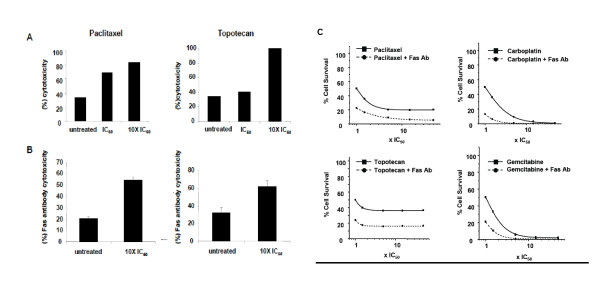
Tumor cells surviving topotecan or paclitaxel are sensitized to effector T cells. (A) In vitro exposure to paclitaxel or topotecan enhances the sensitivity of ID8-E6E7 cells to activated E7-specific T cells. Bars show cytotoxicity after exposure to 2 different doses of paclitaxel and topotecan (IC50 and 10 fold IC50) for the same E:T ratio (20:1). Experiments were performed twice with similar results. (B) Treatment of ID8 cells with topotecan or paclitaxel sensitizes them to Fas agonistic antibody. ID8 cells (untreated or treated with topotecan or paclitaxel at IC50 as described) were incubated with the Fas agonistic antibody and recombinant protein G or with isotype matched antibody and recombinant protein G for 24 hours, harvested, stained with trypan blue and the viable cells were counted (hemocytometer). The bars show the mean level of cytotoxicity and standard errors of three independent experiments. (C) The addition of Fas agonistic antibody to paclitaxel (upper left), carboplatin (upper right), topotecan (lower left) or gemcitabine (lower right) in vitro targets the resistant ID8 tumor cells and shifts the plateau phase of the dose-response curve for paclitaxel and topotecan downwards. The sigmoid curves represent the fit of the obtained data to a logistic regression dose response curve.